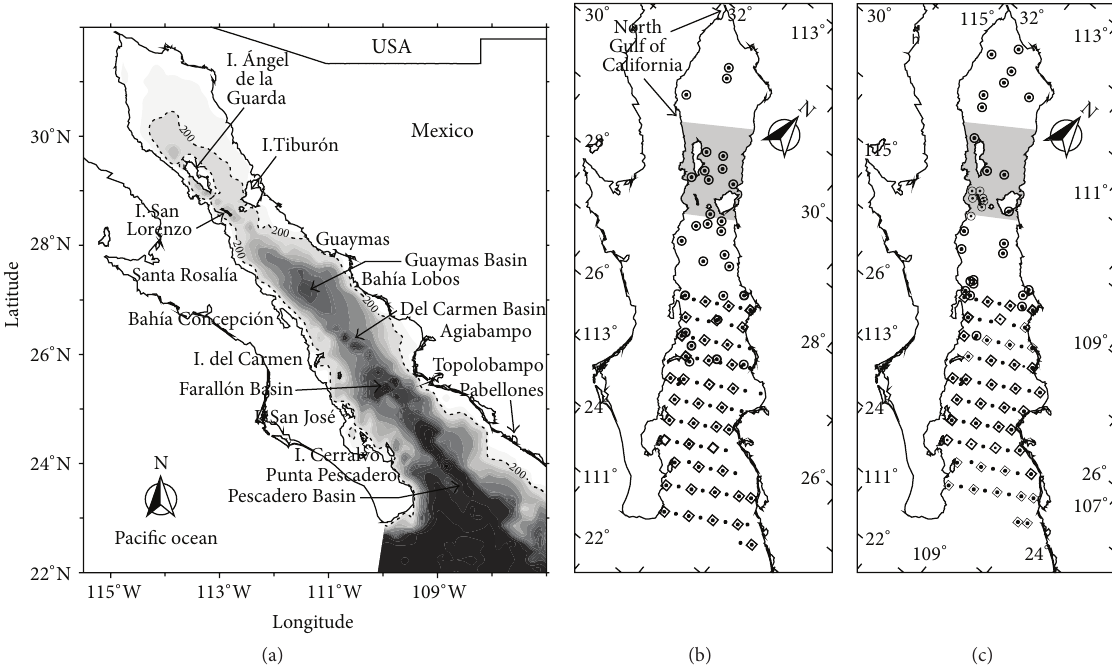
Figure 1: Study area and sampling grid stations in the Gulf of California, Mexico. (a) Localities, some basins, and 200 m isobath. Grid stations during (b) winter and (c) summer. Shaded area indicates the Big Islands Archipelago region. Open circles: GOLCA0701 and GOLCA0707 cruises. Open squares: CGC0503 and CGC0509 cruises. Solid circles: CTD